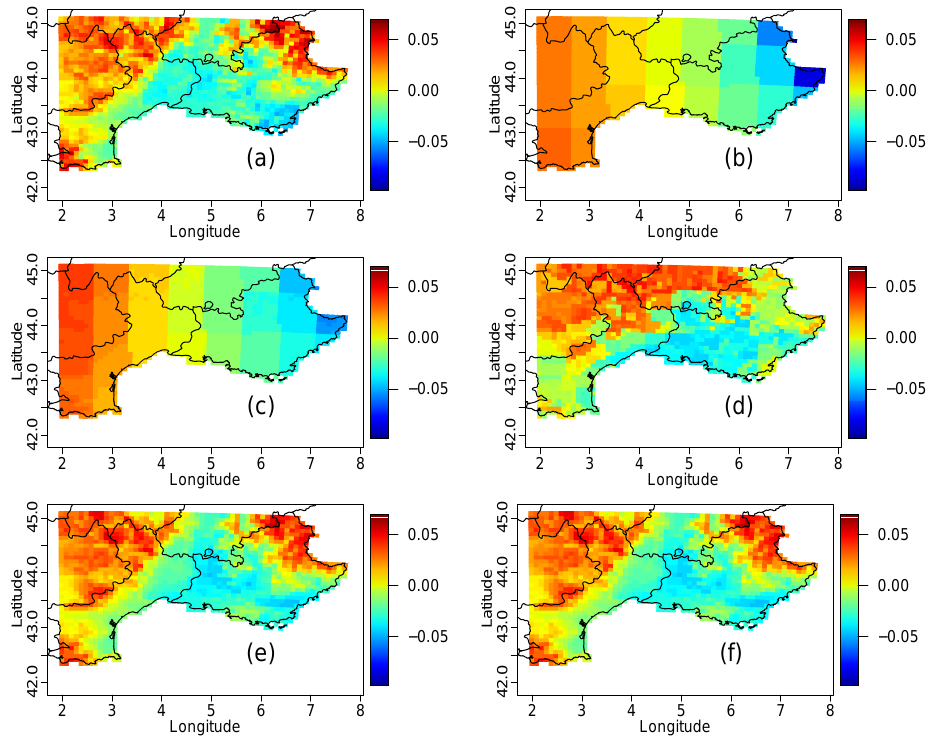
Figure 2. Maps of first temperature predominant empirical orthogonal functions (EOFs) in winter over the evaluation period for (a) SAFRAN; (b) ERA-I; (c) 1d-BC (CDF-t); (d) 2d-R 2 D 2 (with PR as reference dimension); (e) 1506d-R 2 D 2 (on T2 only); (f) 3012d- R 2 D 2